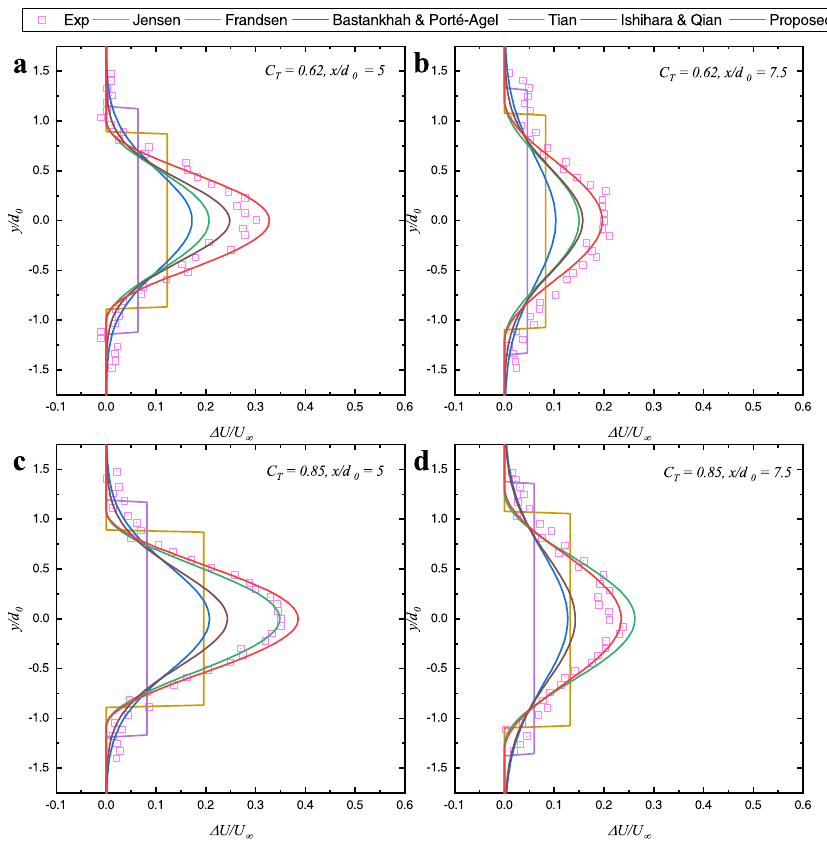
Figure 8. Comparison between the wind-tunnel measurement data and the predicted normalized velocity deficit: ( a ) C T = 0.62, x / d 0 = 5; ( b ) C T = 0.62, x / d 0 = 7.5; ( c ) C T = 0.85, x / d 0 = 5; ( d ) C T = 0.85, x / d 0 =